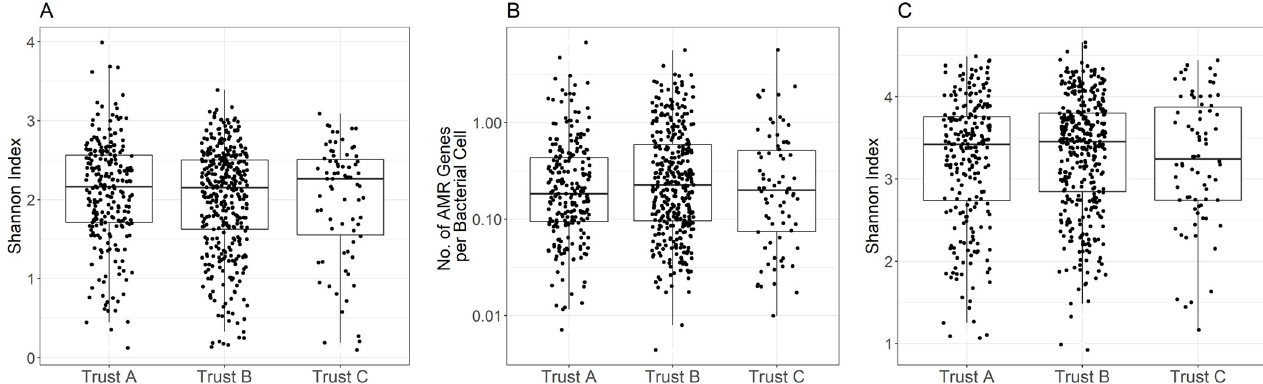
Fig 2. Species diversity and AMR resistance burden among faecal samples by hospital site. A) species alpha diversity, B) AMR gene carriage, C) resistome alpha diversity. https://doi.org/10.1371/journal.pone.0282584.g002 PLOS ONE | https://doi.org/10.1371/journal.pone.0282584 March 16,